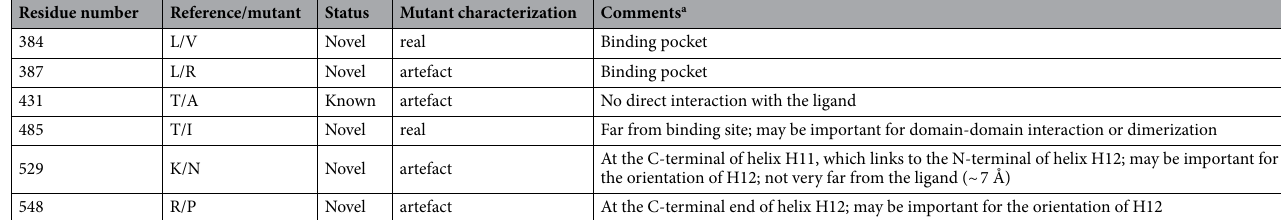
Table 1. SNP missense variants obtained from Sanger sequencing study. a The assumptions of their effects are based solely on the positions of the mutations in the static crystallographic structures (Fig. 1b,c). More studies on structures, dynamics and energetics will be required to confirm or refute these